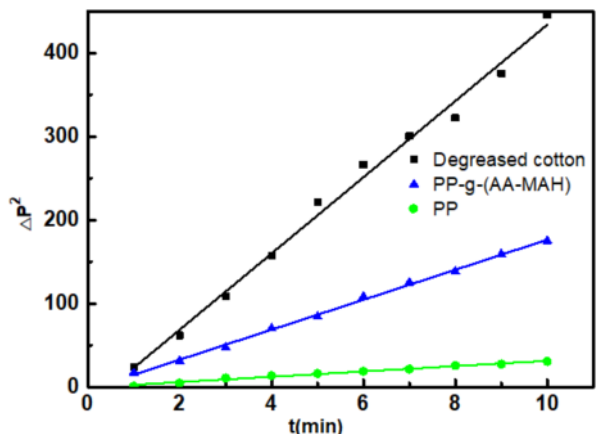
Figure 9. Linear fitting relationship of ( Δ P) 2 of degreased cotton, PP-g-(AA-MAH) and PP fiber with t.